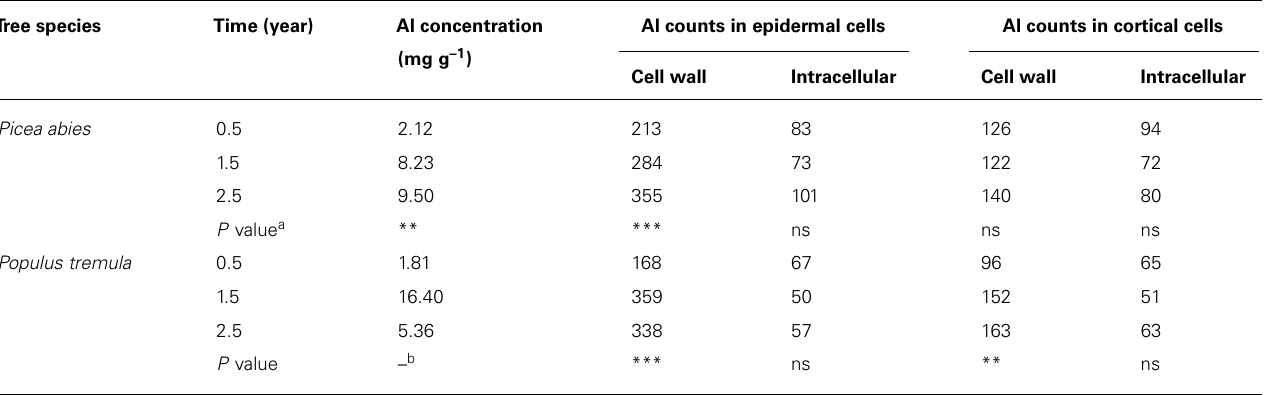
Table 3 |Al accumulation in fine roots of Picea abies and Populus tremula [Al concentrations of bulk material;Al net counts of compartments using , energy-dispersive X-ray spectroscopy (EDX)-analyses] after growth in weakly acidic soil (pH 6.5) with different length of exposition time (according to Brunner etal.,